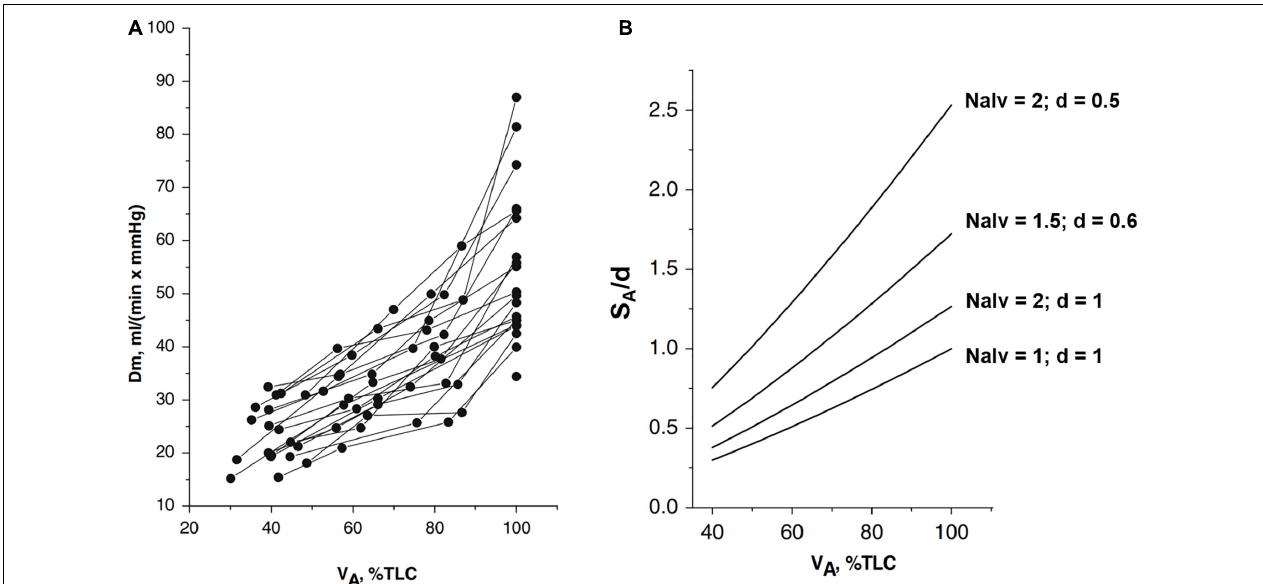
FIGURE 1 | (A) Individual plots of Dm (a membrane diffusing capacity) vs. lung volume ( V A ) from FRC (about 40% TLC ) up to 100% TLC . (B) Numerical simulation to show the lung volume dependence of surface to the thickness ratio of the air-blood barrier ( S A /d ). The various relationships were obtained by changing Nalv (number of alveoli) that affects S A /d , as indicated; for the reference condition, S A , Nalv , and d are set to unity (from Miserocchi et al., 2008).